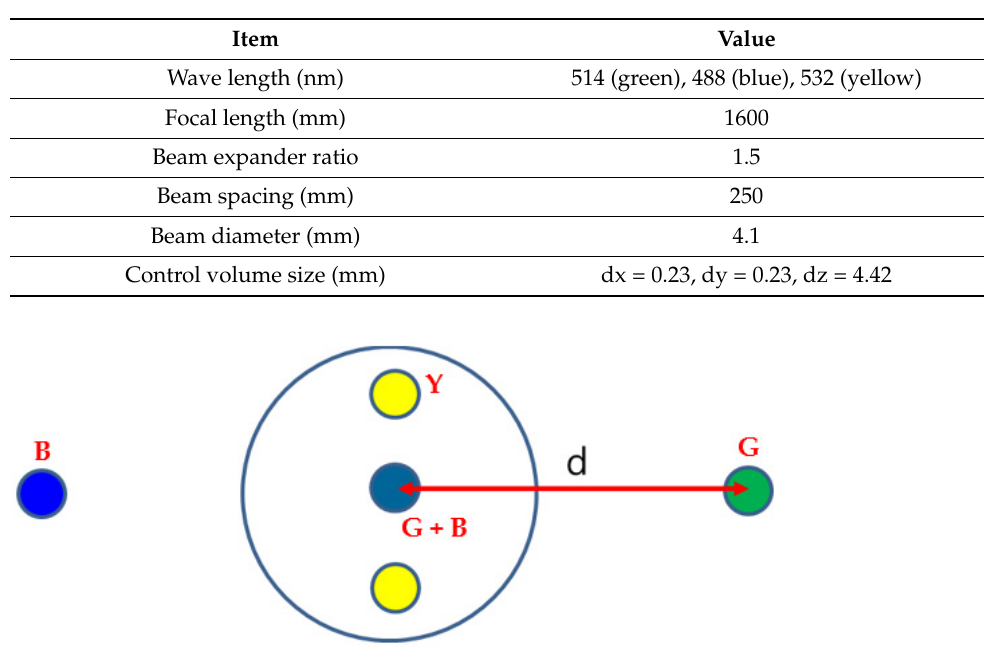
Figure 5. Probe configuration of 3-D LDV system (G: green, B: blue, and Y: yellow, front view).